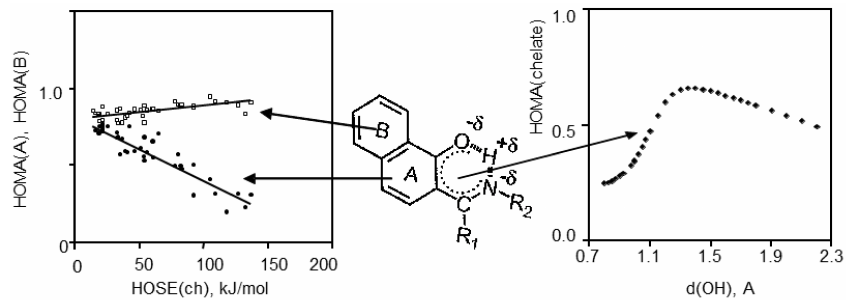
Figure 11. Left side: correlations between HOMA(A), HOMA(B) and (HOSE(ch)) aromaticity indexes calculated on the X-ray diffraction data. Reprinted with permission from [100]. Copyright 2008 John Wiley & Sons, Ltd. Right side: dependency of the aromaticity of chelate chain (HOMA(ch)) depending on the OH bond length calculated on MP2/6-31+(d,p) data. R 1 and R 2 substitutions are hydrogen, alkyl and aryl substitutions.